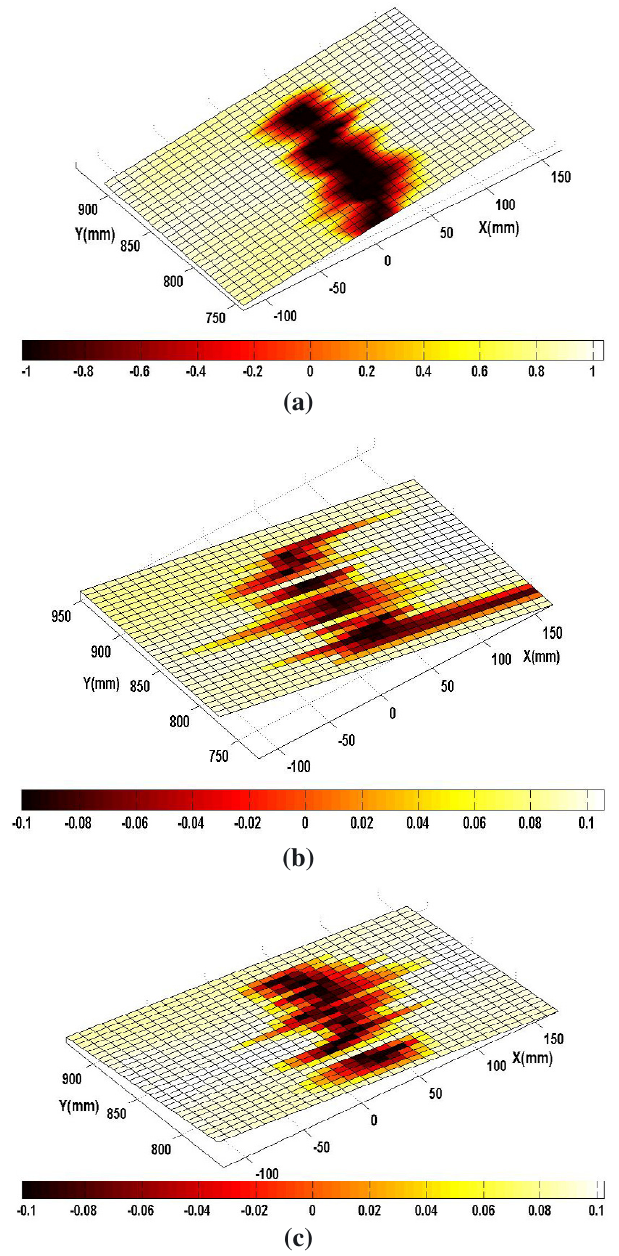
Fig. 4. Evaluated MDZs for randomly selected 200 measured points: (a) data set #1, (b) data set #7, (c) data set